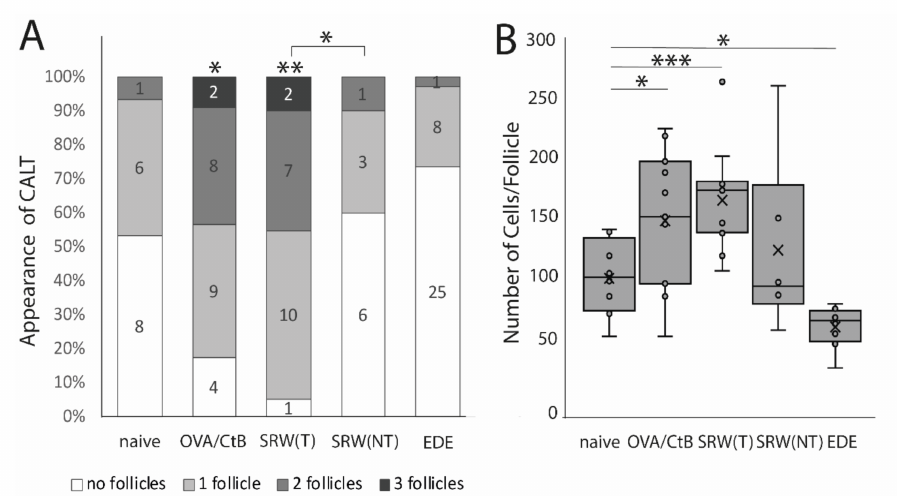
Figure 1. The appearance of conjunctiva-associated tissue (CALT). ( A ) Number of CALT in naïve ( n = 8), OVA / CtB (ovalbumin / Choleratoxin B) stimulated ( n = 12), short ragweed (SRW) allergy (T-treated; NT non-treated eye) ( n = 15), and experimental dry-eye (EDE) ( n = 17) mice. The number provided in the bars show the number of eyes investigated. Topical stimulation with OVA / CtB or SRW pollen leads to a significant increase in the number of follicles compared to naïve mice. Topically unchallenged eyes of immunized mice demonstrated significantly less CALT than stimulated SRW eyes, but no di ff erences compared to naïve mice. ( B ) Average cell number per follicle. OVA / CtB and SRW mice had significantly bigger follicles compared to naïve. There was no di ff erence between stimulated and non-stimulated